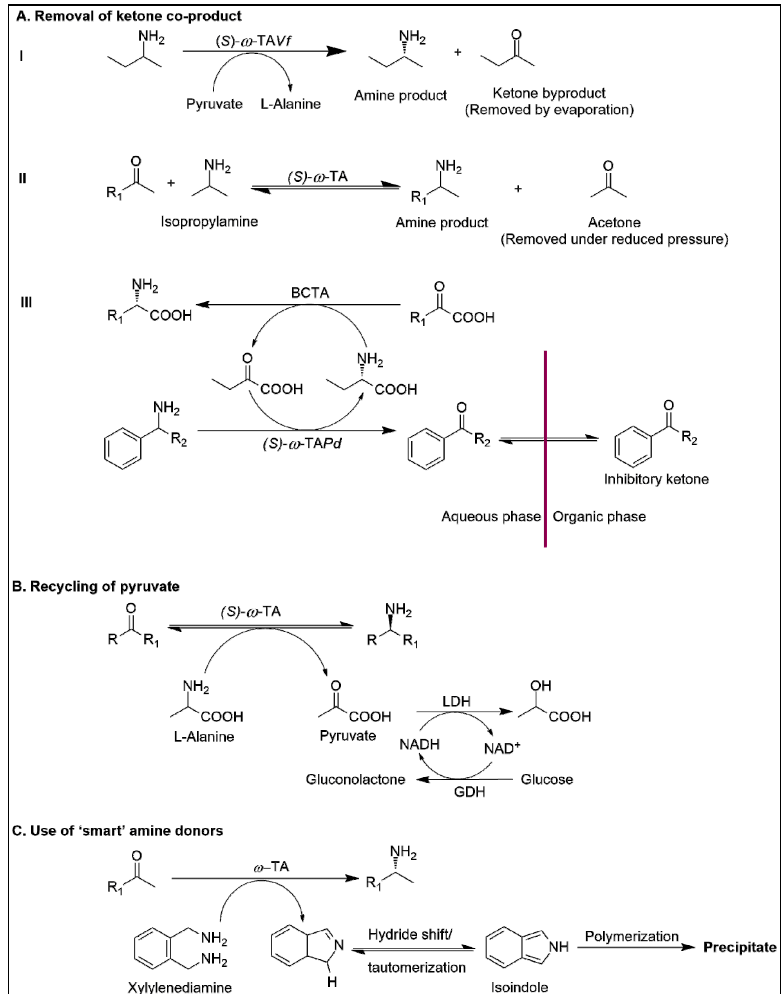
Figure 3. Various strategies used to shift the equilibrium of ω -TA mediated transamination: ( AI ) Removal of ketone byproduct by evaporation; ( AII ) Removal of ketone byproduct under reduced pressure; ( AIII ) Removal of ketone byproduct using biphasic reaction system; ( B ) Recycling of pyruvate substrate; and ( C ) Use of ‘ smart ’ amine donors (BCTA- Branched-chain amino acid transaminases; LDH-Lactate dehydrogenase; GDH-Glucose